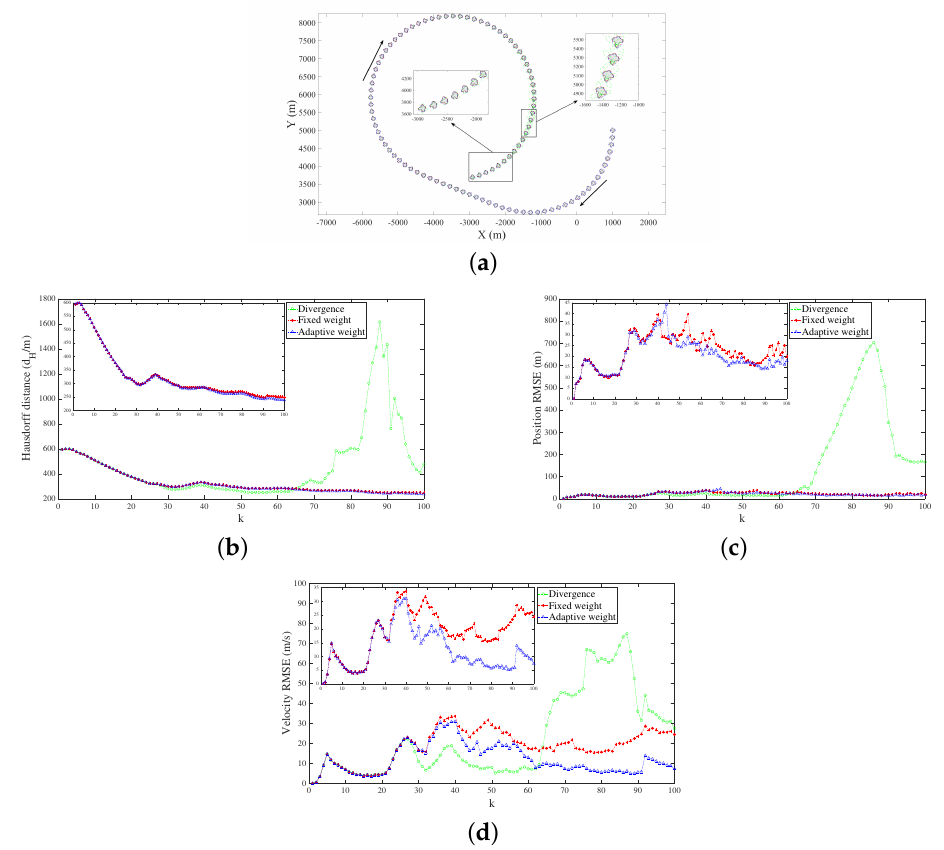
Figure 11. The performance comparisons of the three algorithms in RS. ( a ) Trajectory. ( b ) Hausdorff distance. ( c ) RMSE of position. ( d ) RMSE of